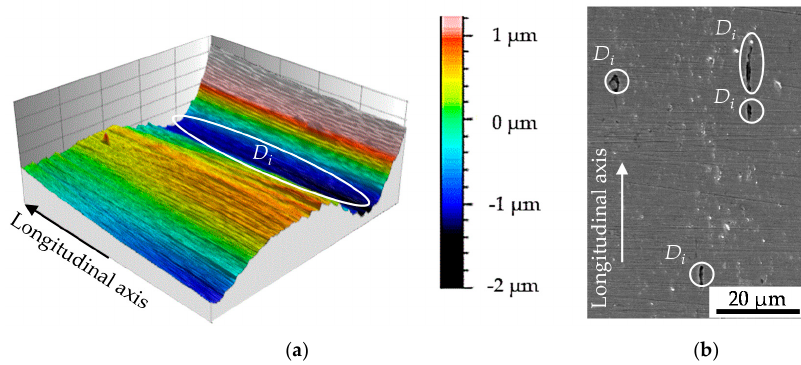
Figure 2. ( a ) Surface profile of the specimens; indicating a exemplary depth of initial damage ( D i ) of up to 2 µm; ( b ) Forming-induced initial damage ( D i ) at the specimen surface after